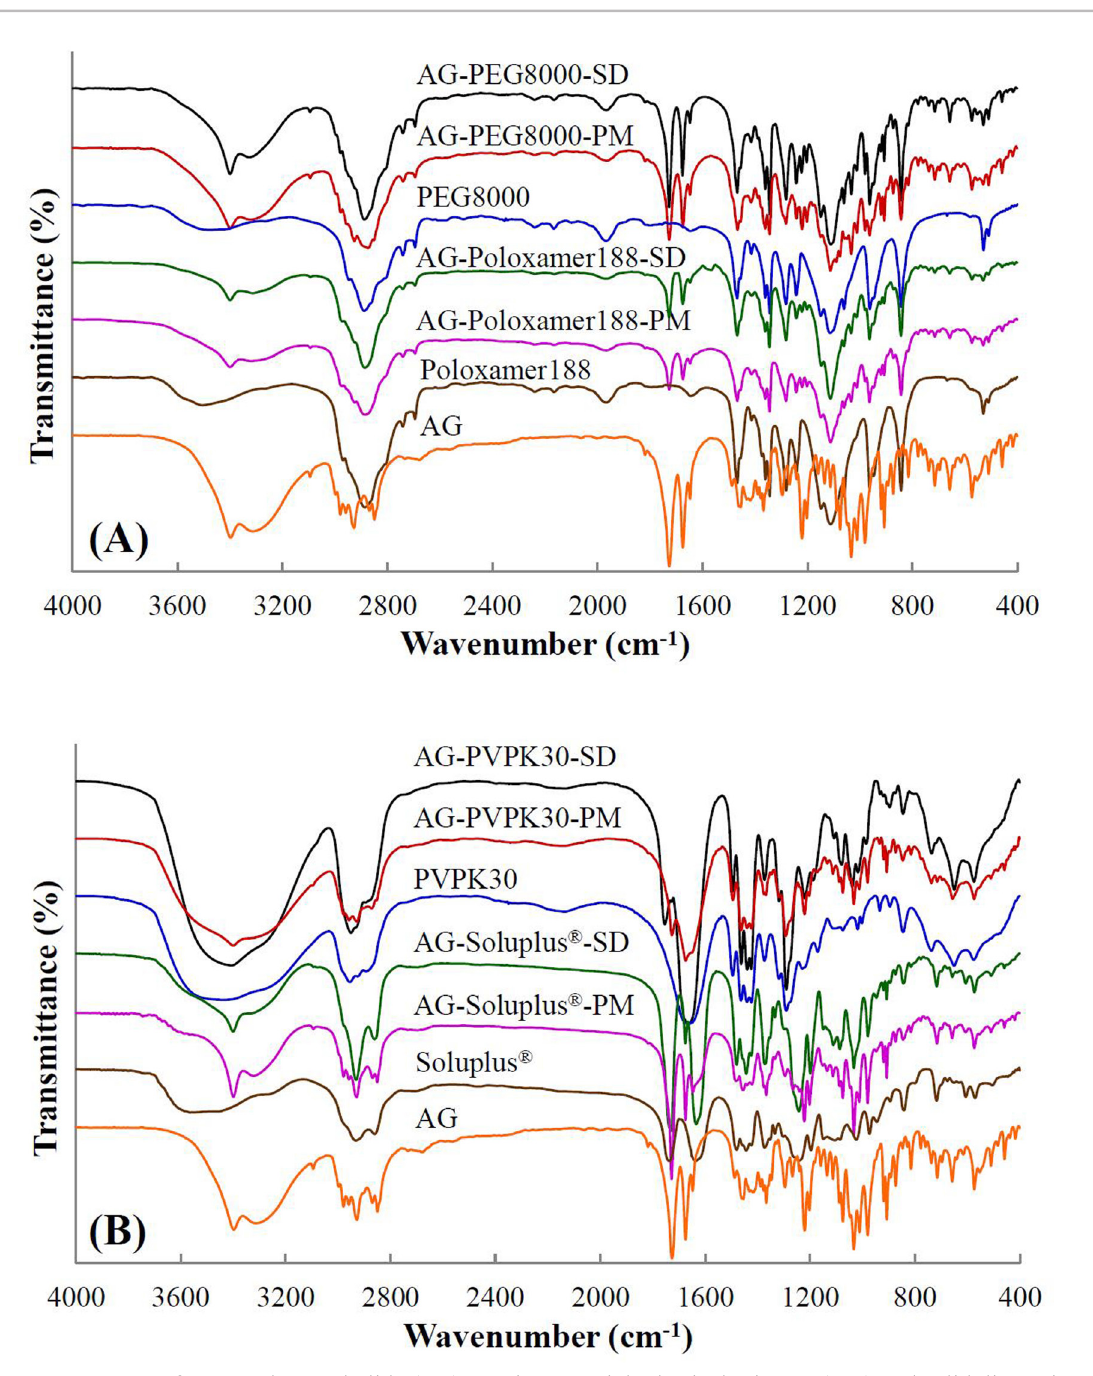
FIGURE 1 - FT-IR spectra of pure andrographolide (AG), carrier material, physical mixture (PM) and solid dispersion (SD) (A) PEG8000 and Poloxamer188 as carrier materials, (B) PVPK30 and Soluplus ® as carrier